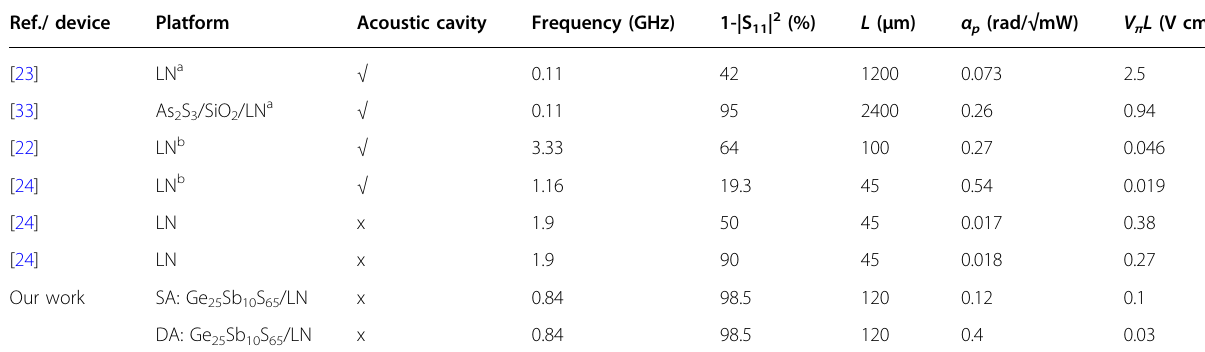
Table 1 Comparison of modulation metrics for TFLN MZI-based AO modulators. Ref./ device